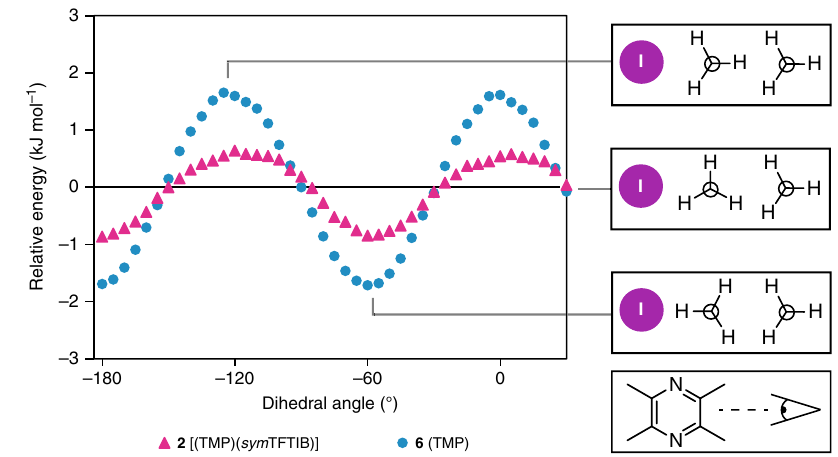
Fig. 4 DFT-calculated relative energy as a function of the methyl group dihedral angle (H – C – C – C). The blue circles denote pure TMP ( 6 ) and the magenta triangles denote cocrystal 2 . A diagram showing the methyl group geometry at the energy maximum, zero-crossing, and minimum is shown on the right. A depiction showing the perspective in the diagram is shown on the bottom right